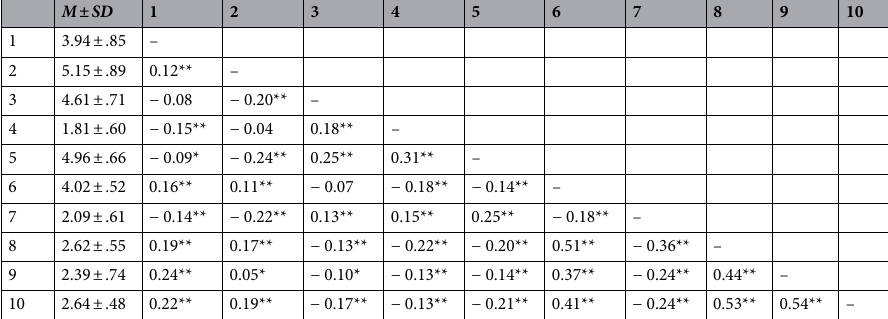
Table 1. Pearson’s correlation coefficients of the study variables. 1, psychological adaptation; 2, activity level; 3, rhythmicity; 4, approach/withdrawal; 5, quality of mood; 6, spoiling parenting; 7, democratic parenting; 8, indulging parenting; 9, authoritarian parenting; 10, disaccording parenting. * p < 0.05, ** p < 0.01.